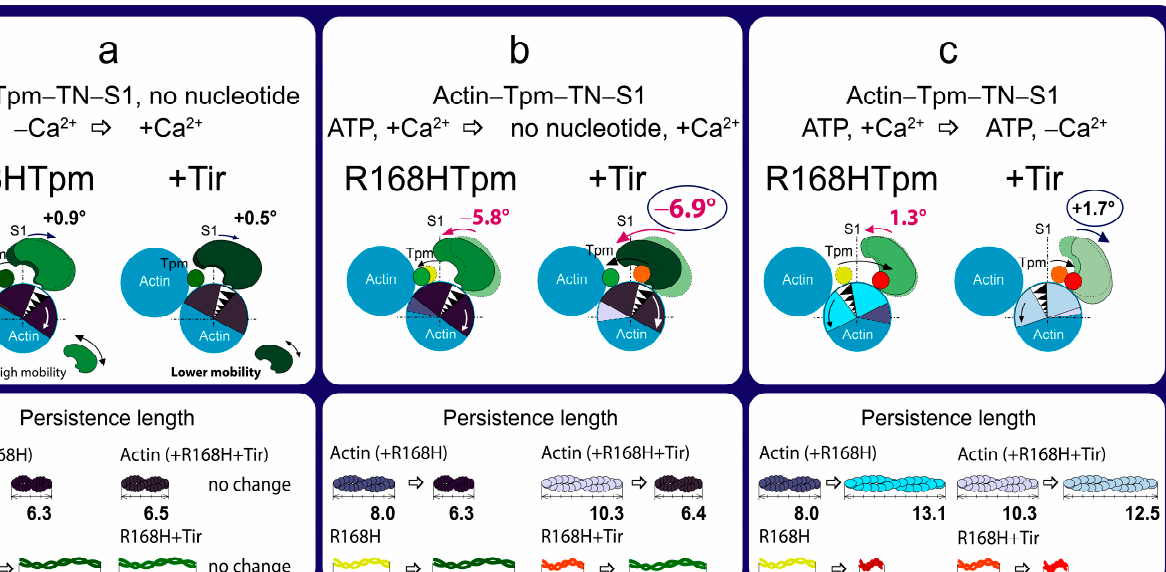
Figure 11. Effect of 5 μ M tirasemtiv (Tir) on the values of Φ E ( a ), ɛ ( b ), and N ( c ) of polarized fluo- rescence of S1-AEDANS in the presence of WTTpm or R168HTpm revealed in ghost muscle fibers under conditions simulating the sequential steps of the actomyosin ATPase cycle. The fluorescence parameters presented here are compared with the data obtained in the same experiment when the muscle fibers containing the WTTpm were used as a control. The data are presented as mean ± SEM. * p < 0.05 = difference between WTTpm and R168HTpm–Tir.